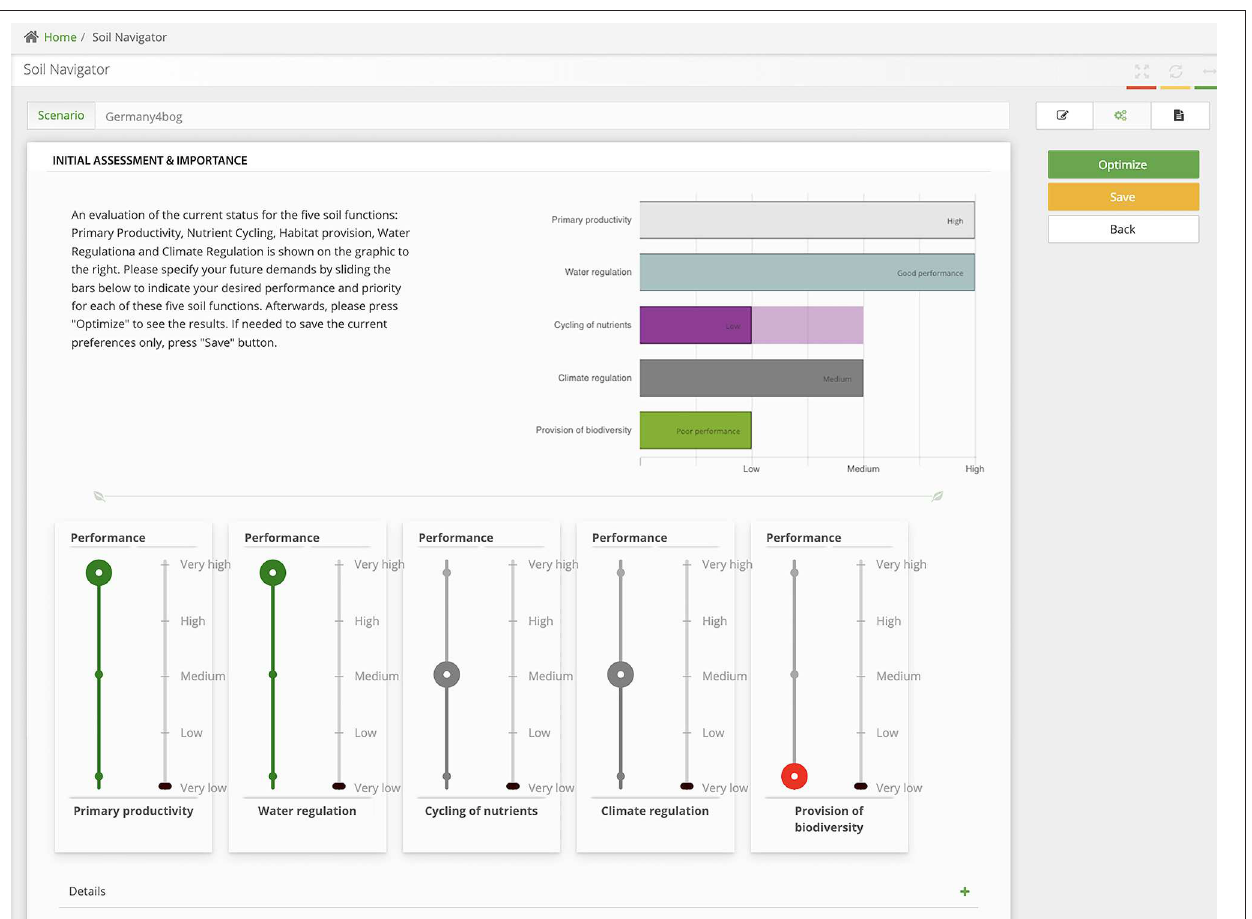
FIGURE 5 | Outputs from the assessment of the soil functions and specification of their